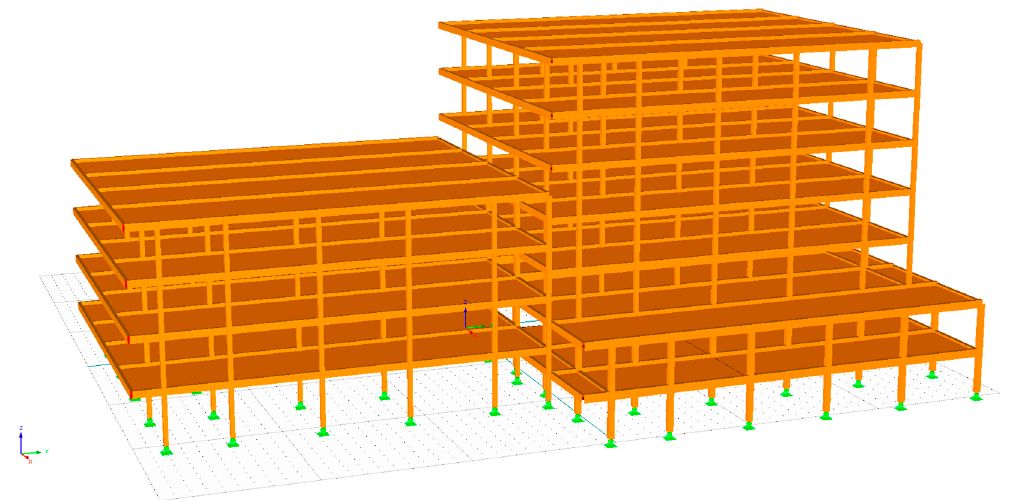
Figure 8. FE model of two interacting wood-framed buildings.